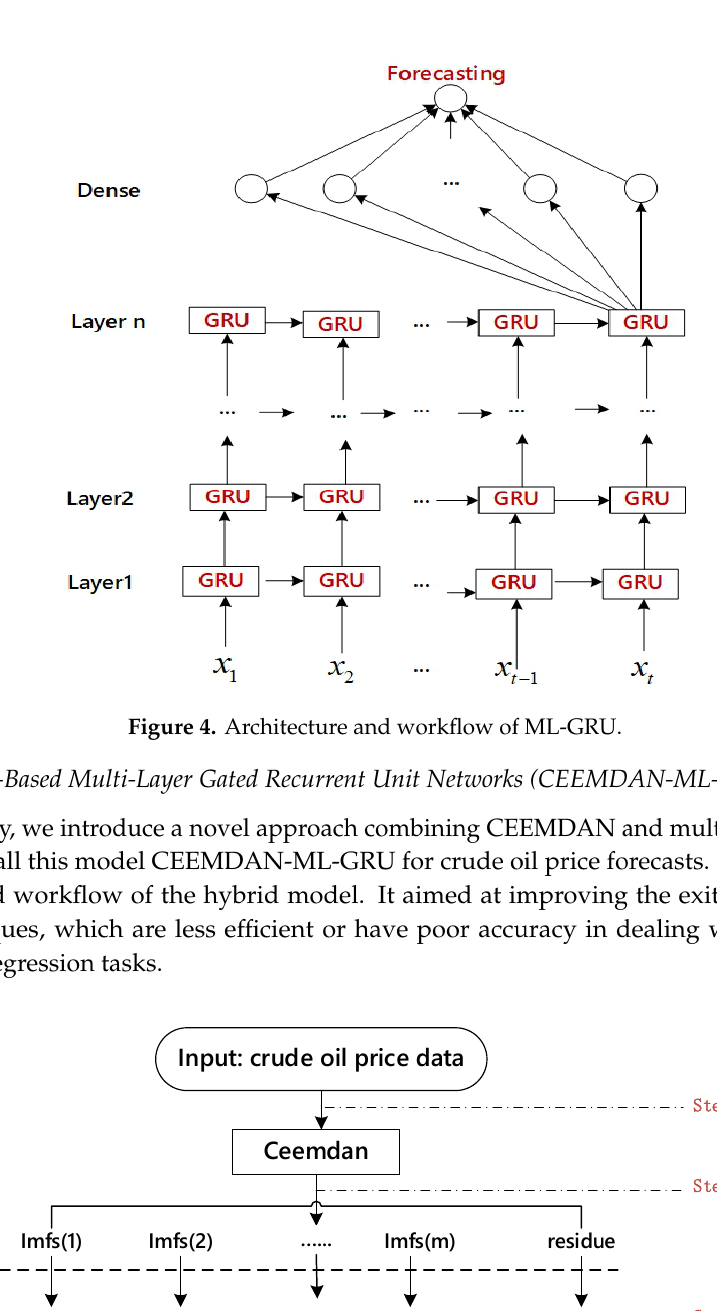
Figure 5. CEEMDAN-based Multi-layer Gated Recurrent Unit Networks (CEEMDAN-ML-GRU). This approach adopts a strategy of “divide and process”, which transforms a complicated issue into Several simple issues, and processes them independently.